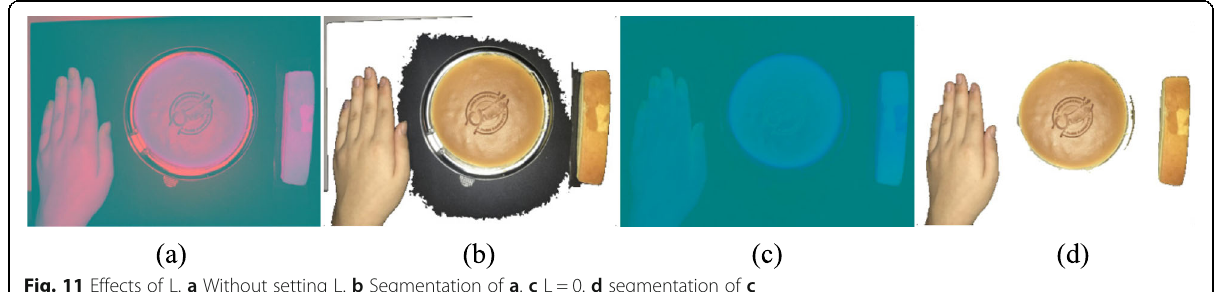
Fig. 11 Effects of L. a Without setting L. b Segmentation of a . c L = 0. d segmentation of